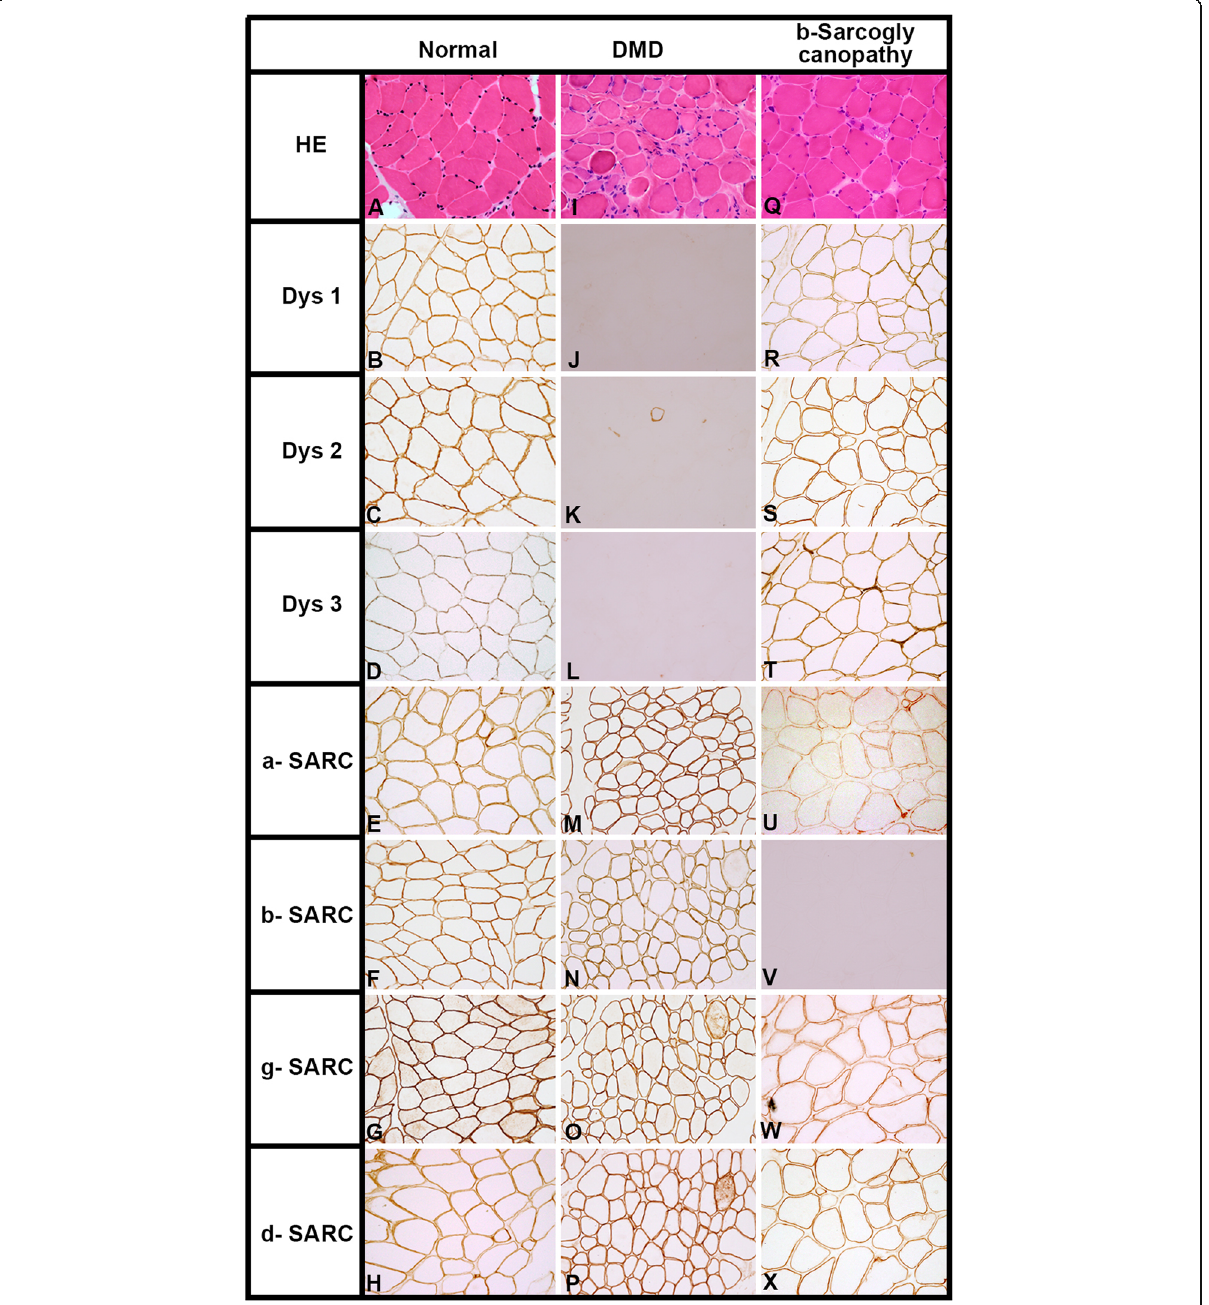
Fig. 3 Transversely cut skeletal muscle tissue shows dystrophic features on HE staining in both DMD and β - sarcoglycanopathy (Fig I & Q) as against normal muscle tissue (Fig A). Immunohistochemically, antibodies against dystrophin (dys1,2,3) and sarcoglycans ( α , β , γ , δ ) shows preserved expression along the membrane in all the fibres (Fig B-H) in normal muscle tissue, while total loss of expression for dystrophin (Fig J,K,L) and preserved expression for sarcoglycans (Fig M,N,O,P) indicates the diagnosis of the DMD. Note: Preserved expression of dystrophin (Fig R,S,T) and δ & γ sarcoglycans (Fig W,X) reduced α -sarcoglycan (Fig U)and complete absence of β -sarcoglycan (Fig V) in a case of